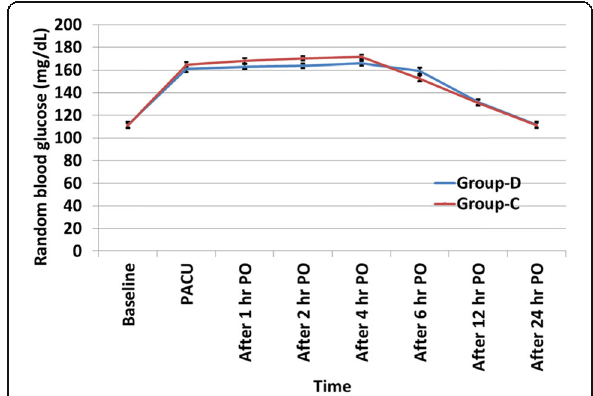
Fig. 4 Comparison between the C group and D group according to random blood sugar (< 180 mg/dl)